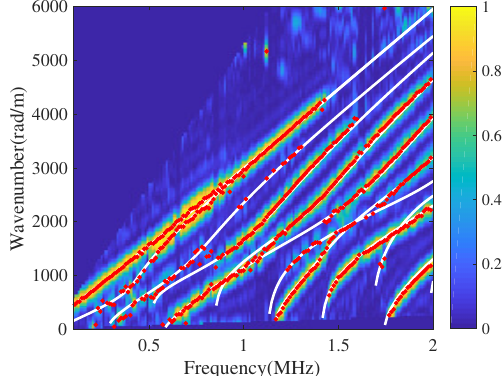
Figure 4. Wavenumbers of the 4-mm-thick copper plate estimated using the conventional singular value decomposition (SVD) method. The color intensity map shows the results obtained using the conventional SVD method. Solid white lines show the theoretical curves.